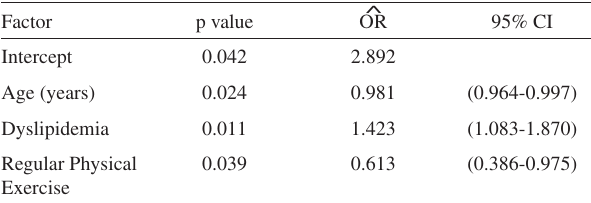
Table 4 - Logistic regression model to explain lower scores in the environmental domain